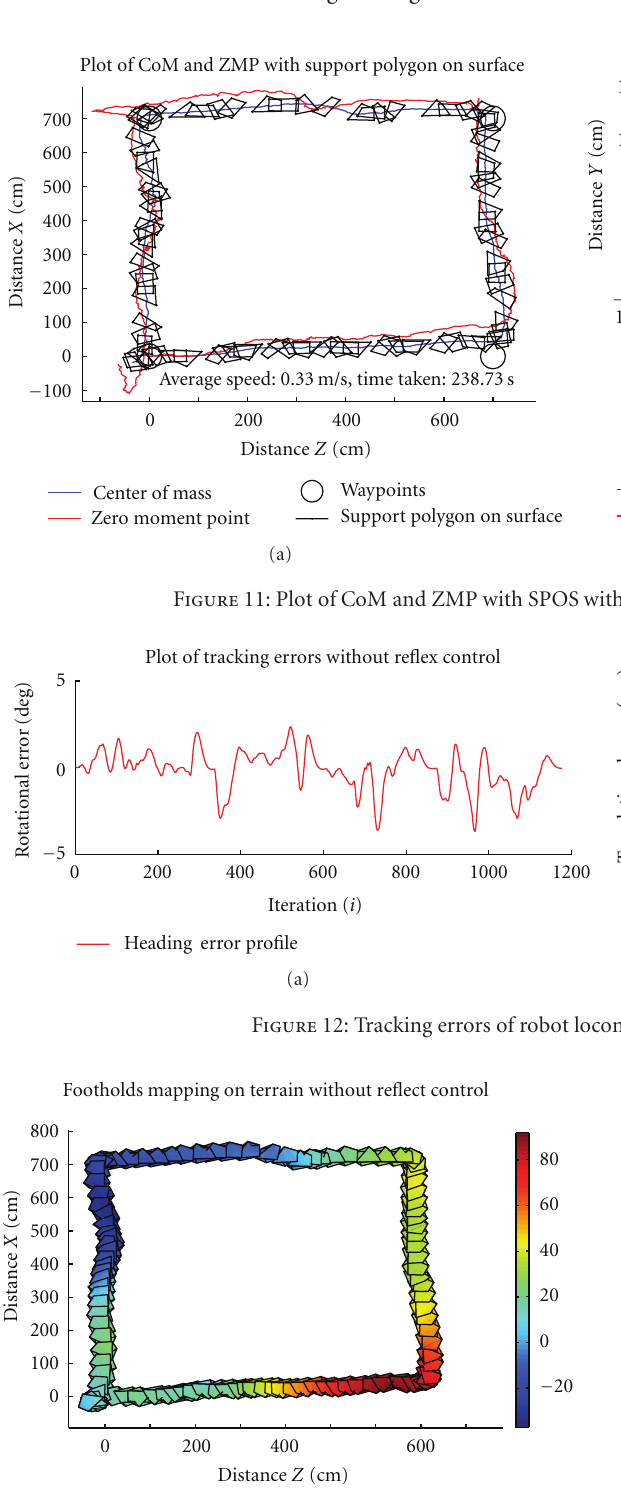
Figure 13: Terrain intercepted by the robot without using the FRC method.